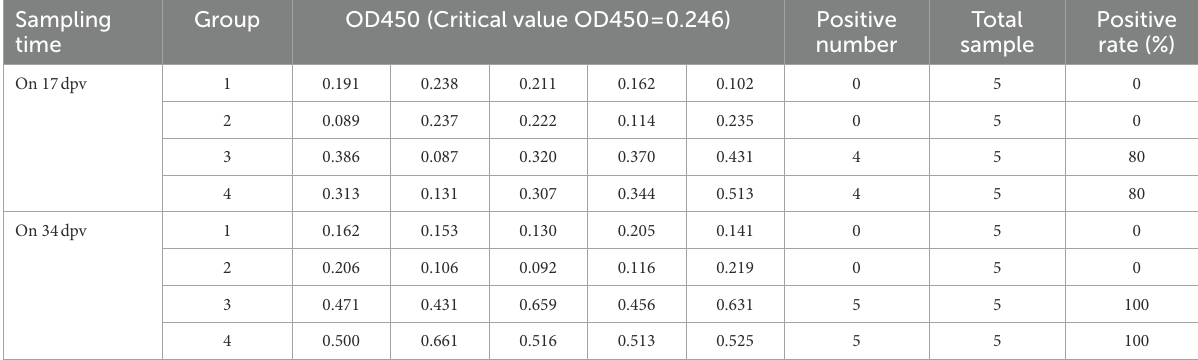
TABLE 2 The levels of p30 IgG antibody in serum of rabbits.